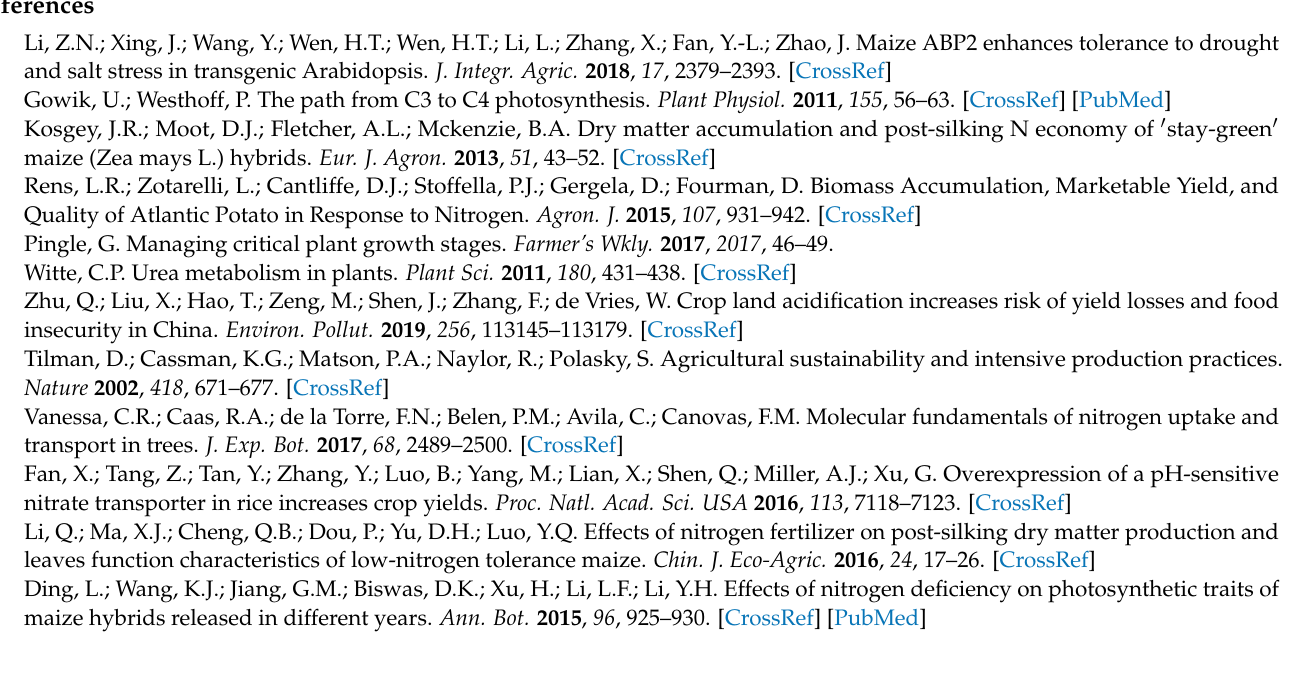
diagram of Area II; Figure S2: GO enrichment analysis result diagram of Area III; Figure S3: Enriched KEGG pathways of Area II; Figure S4: Enriched KEGG pathways of Area III; Figure S5: Correlation between qRT-PCR and TMT-Seq; Table S1: Details of protein identification; Table S2: Enriched GO terms of Area I; Table S3: Enriched GO terms of Area II; Table S4: Enriched GO terms of Area III; Table S5: Enriched KEGG pathways of Area I; Table S6: Enriched KEGG pathways of Area II; Table S7: Enriched KEGG pathways of Area III; Table S8: Relative expression levels of genes; Table S9: Cis-acting elements contained in the ZmTGA promoter